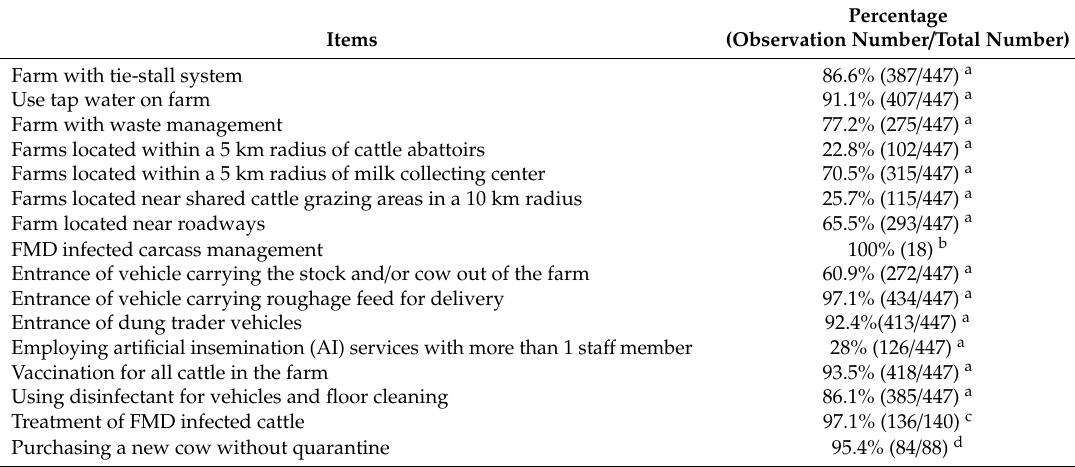
Table 1. Descriptive findings for general farm management practices, animal and vehicle movement, vaccination of animals and farm biosecurity in the study